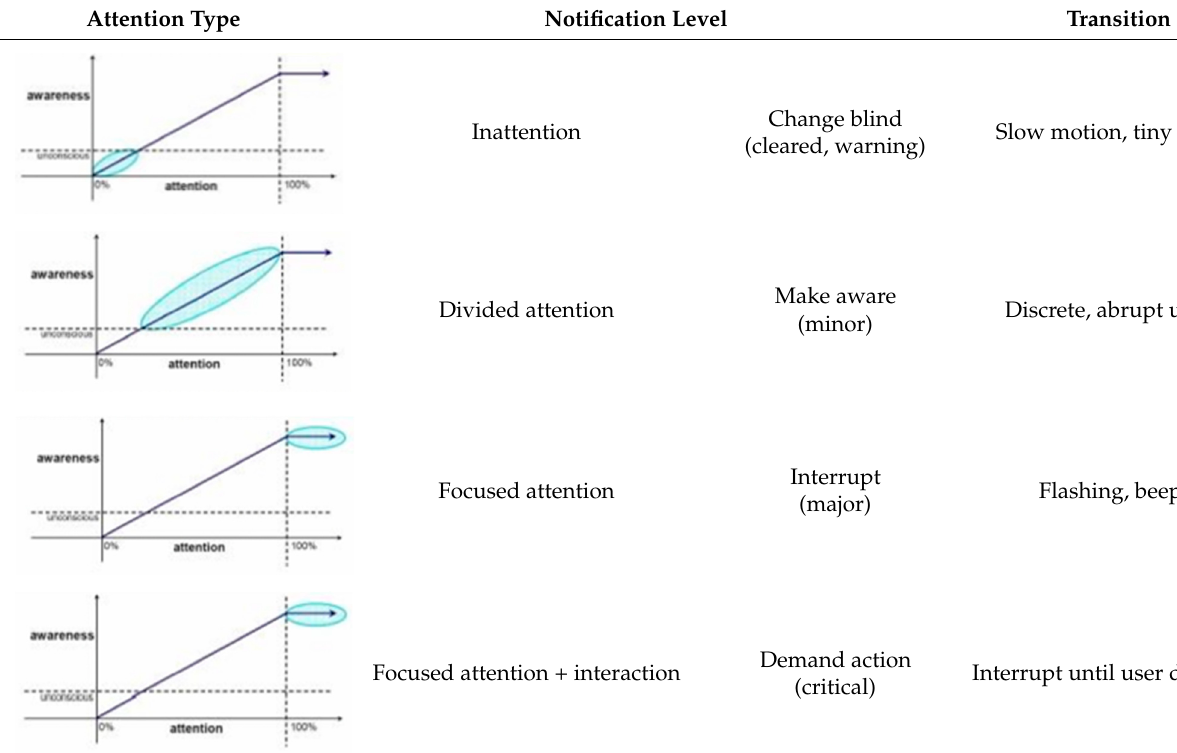
Table 5. Mapping severity levels to attention types/transition types of [38].